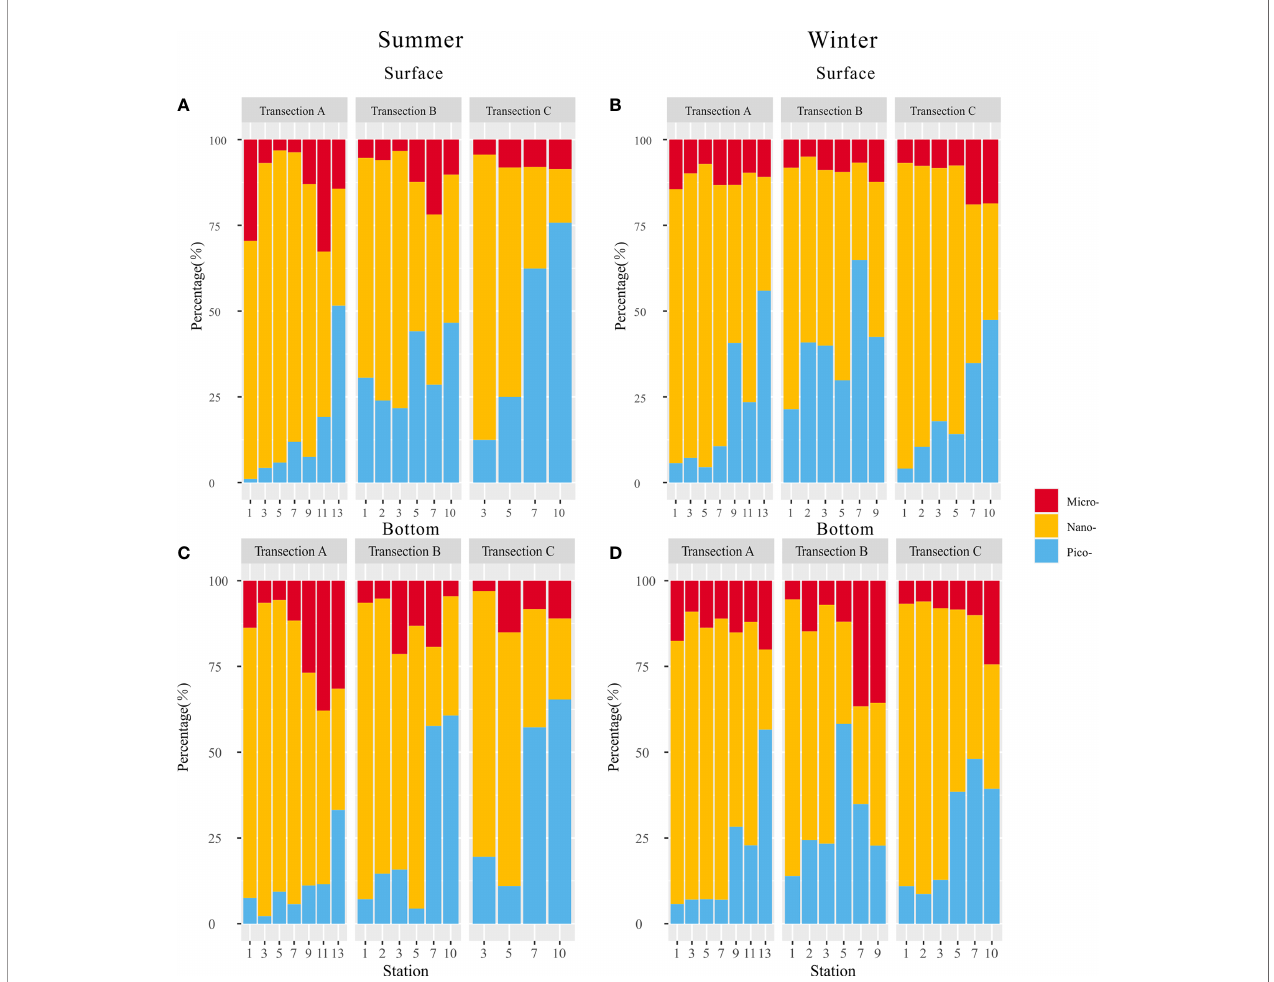
FIGURE 3 | Contribution (%) of three cell size-fractioned Chl a in surface and bottom seawater along transections (A – C) of the GGBA in summer (A – C) and winter (B, D)